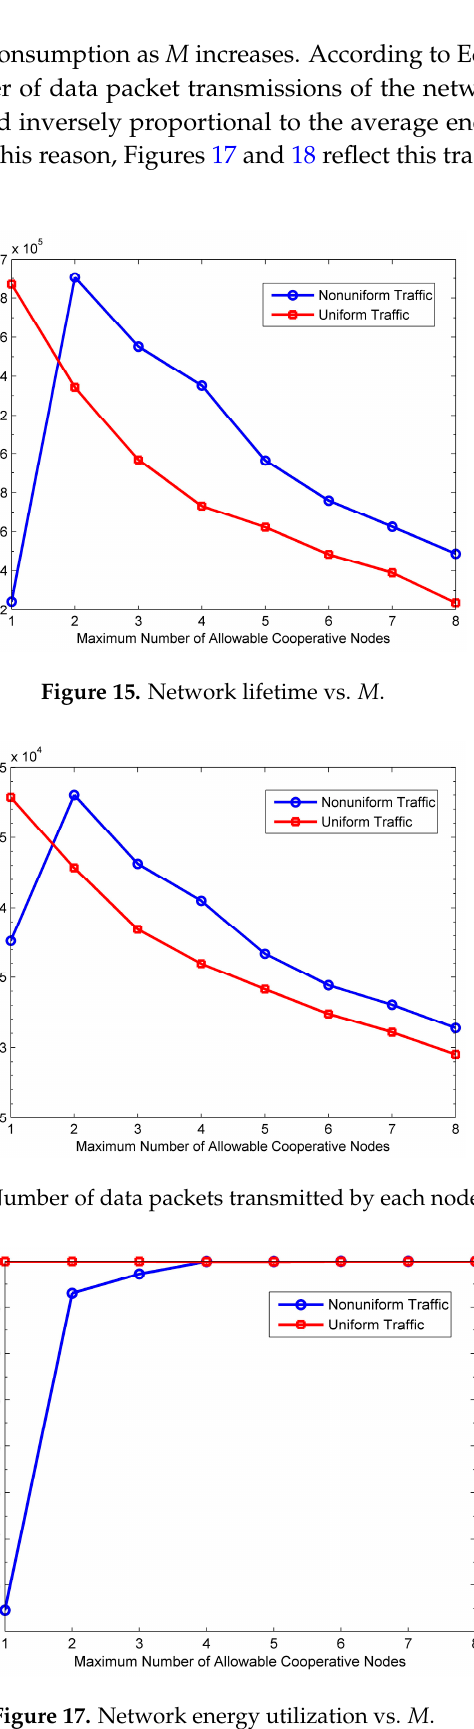
Figure 18. Average consumed energy of each data packet transmission vs. M . As shown in Figure 17, at the uniform network traffic load, the energy utilization of the PO- CMAC protocol is always close to 1. This is because each node can transmit almost the same number of data packets and consume similar amount of energy, which leads to similar residual energy. In this case, selecting a single cooperative node with the best channel quality (i.e., M = 1) can obtain cooperative diversity gain, and meanwhile the LETPO algorithm can balance the network energy consumption efficiently, which guarantees high energy utilization. At this time, if M is further increased, there is no room for improving energy utilization. At the non-uniform network traffic load, the network energy utilization increases significantly with the increase of M and then approach to 1 smoothly. This is because the different packet arrival rates lead to the differences in the energy consumption and residual energy of each node. For M = 1, the LETPO algorithm can only balance the residual energy of the sender and a single cooperative node. Furthermore, it is possible that both these two nodes have little residual energy. Therefore, it might fail to balance the local network energy consumption when the network traffic load is non-uniform, which leads to low network energy utilization. With the increase of M , it is more possible for the PO-CMAC protocol to choose cooperative nodes with both higher quality link and sufficient residual energy in cooperative node selection phase. Meanwhile, the LETPO algorithm can balance the residual energy of nodes within a larger local network, thus improving the network energy utilization. Figure 17 shows that, when M is changed from 1 to 2, the improvement of the energy utilization is the largest. Furthermore, as shown in Figure 18, the average energy consumption of each data packet transmission increases with the increase of M at both uniform traffic load and non-uniform traffic